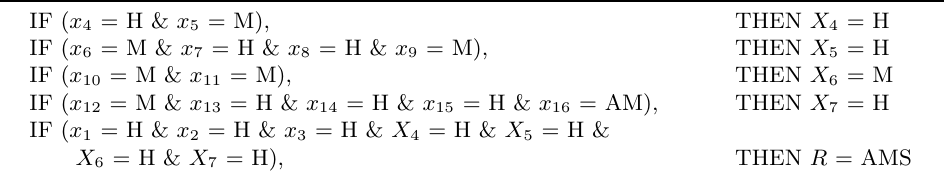
Table 6: Fragment of the fuzzy inference system for